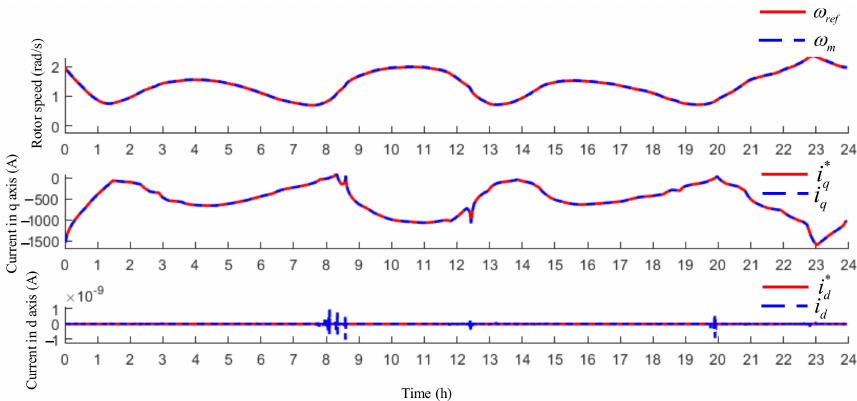
Figure 4. Rotor speed and d–q axis current in the machine-side